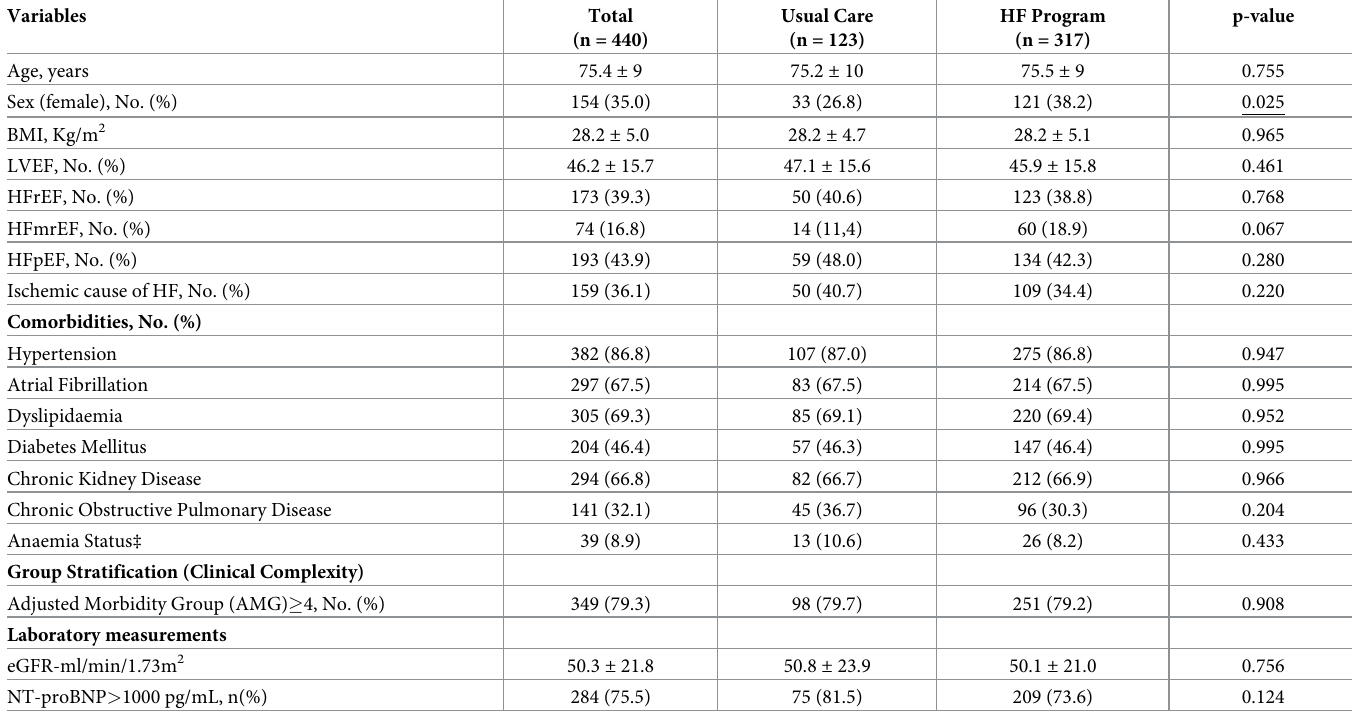
Table 1. Demographics and baseline characteristics of the overall study population and according to intervention